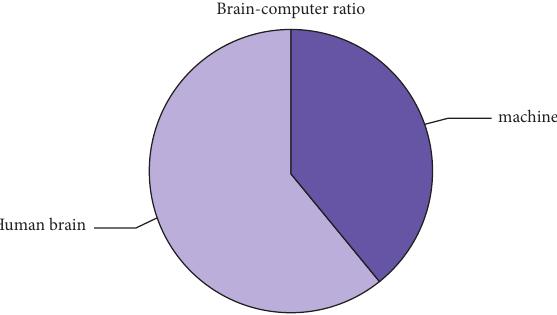
Figure 5: Percentage of human brains and machines in design